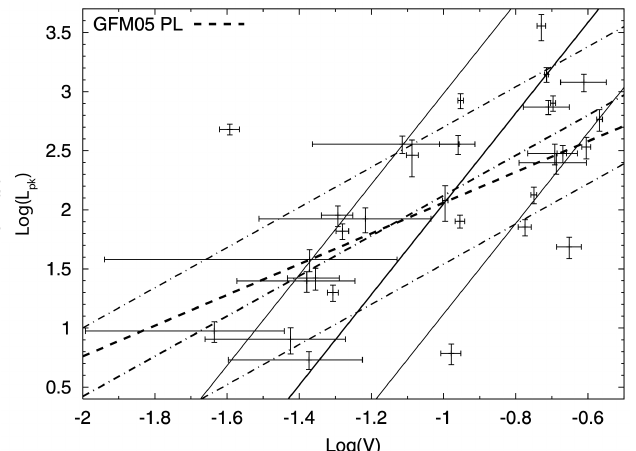
Figure 2. The L pk − V relation taken from Guidorzi et al. [91], who used a number of different methods to calculate variability. Shown are the 32 GRBs with known redshifts that were analyzed by Guidorzi et al. [65]. The relationship that they obtained is plotted as the black dashed line. Also plot- ted are the L pk − V relations obtained with two independent methods of calculating the slope of the relationship. The method outlined by Reichart and Nysewander [90] and Reichart et al. [89] is shown as the solid line with its 1 σ confidence interval. The Bayesian method outlined by D’agostini [92] is shown as the dashed-dotted line with its 1 σ confidence interval (Credit: Guidorzi, et al., The slope of the gamma-ray burst variability/peak luminosity correlation. MNRAS, 2006, 371, 843–851. By permission of Oxford University Press on behalf of MNRAS.